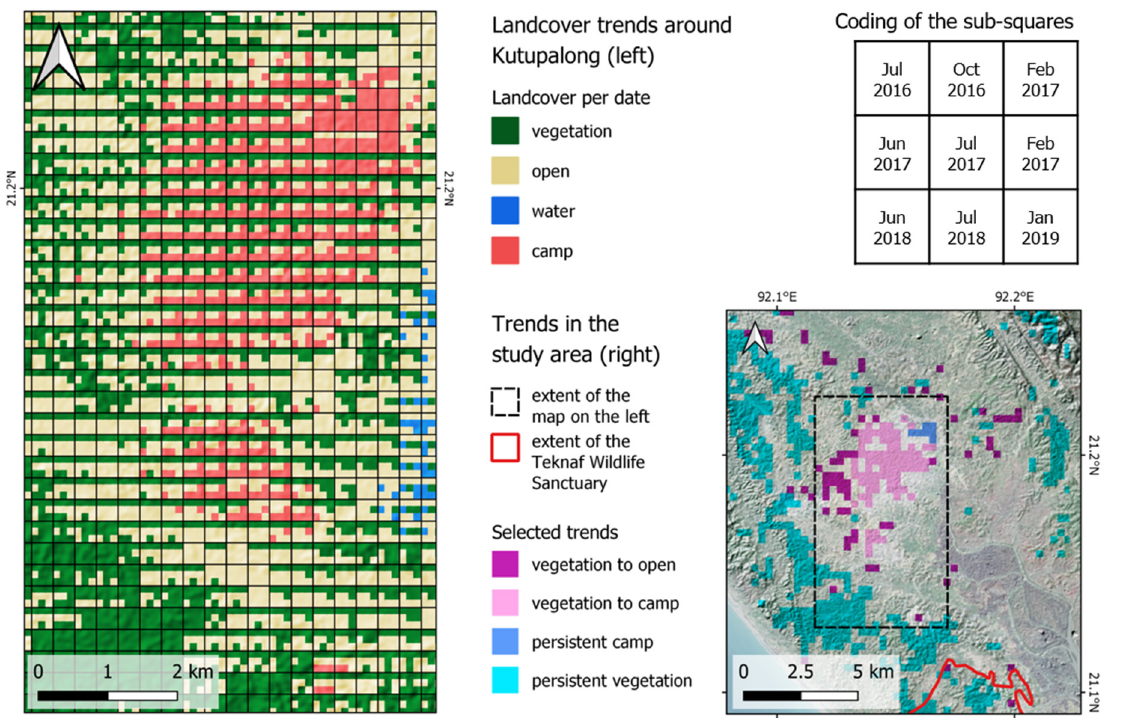
Figure 7. Land cover change between July 2016 and January 2019. Left: area around Kutupalong. Each square consists of nine sub-squares representing the dominant land cover for each date, as coded in the legend on the top right. Right: selected trends in the entire study area based on the three first and last dates.